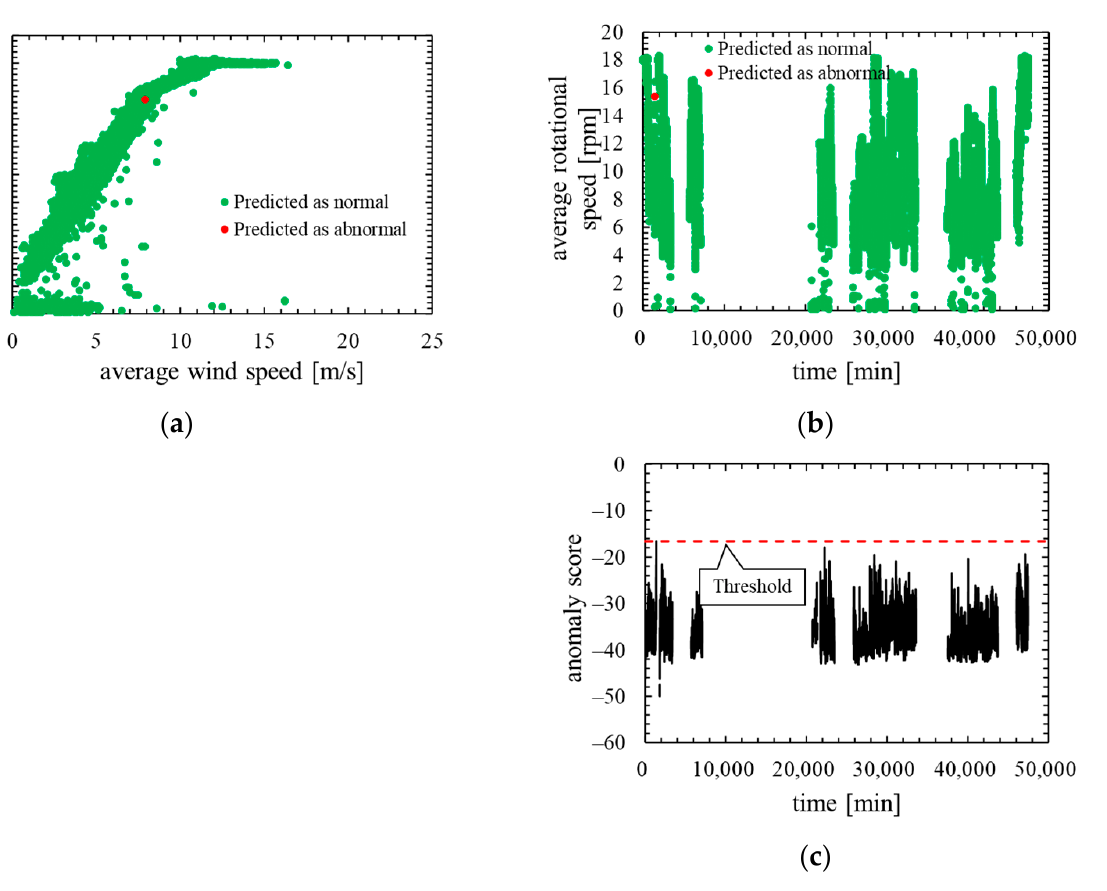
Figure 13 . Training data of the model in which the number of mixture components K was 128 (threshold is 100th percentile’s value): ( a ) wind speed rotational speed characteristic; ( b ) time characteristics of rotational speed; ( c ) time characteristics of anomaly score.